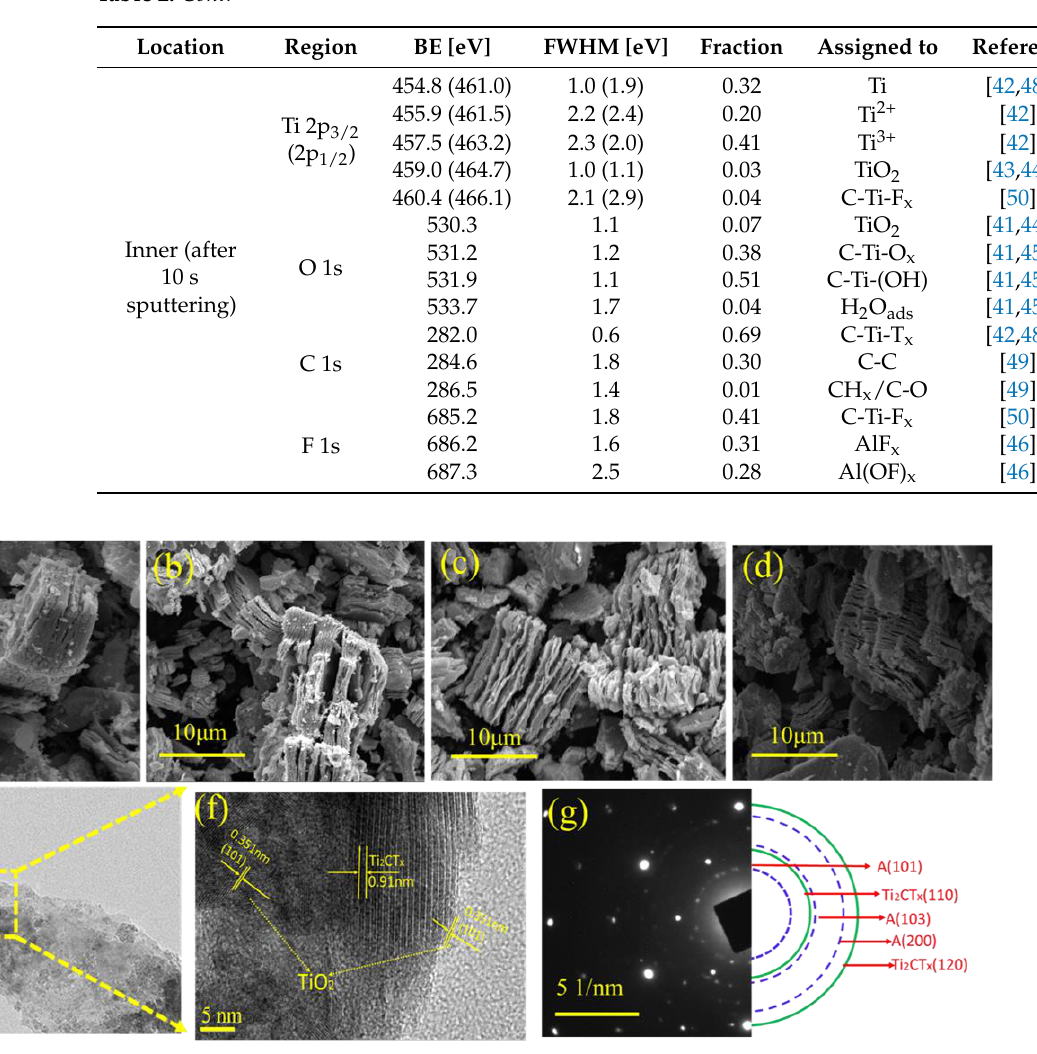
Figure 6. FESEM image of Ti 2 CT x after decomposition of AP ( a ) AP-5 wt.%Ti 2 CT x , ( b ) AP-10 wt.%Ti 2 CT x , ( c ) AP-20 wt.%Ti 2 CT x , and ( d ) AP-30 wt.%Ti 2 CT x . ( e ) TEM image of Ti 2 CT x after decomposition of AP and its ( f ) high-resolution TEM image, as well as ( g ) SEAD patterns. “A” stands for anatase-TiO 2 .